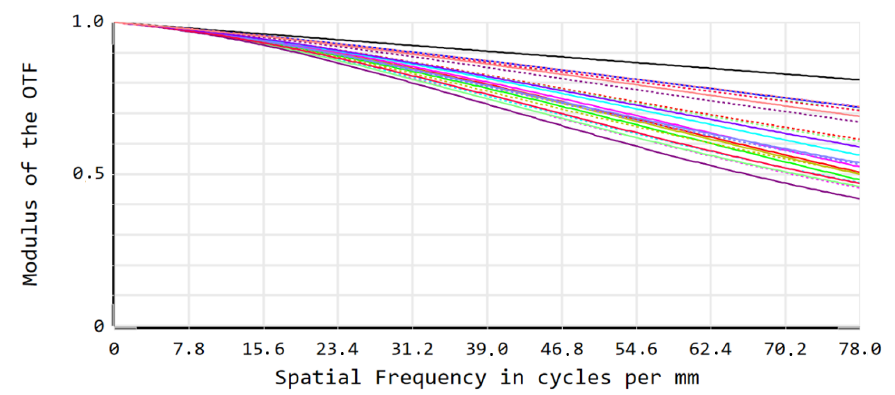
Figure 5. MTF ≥ 0.4 at 78 cycles/mm. The top black line corresponds to the diffraction limit, and the colors correspond to the different fields, similarly to those presented in Figure 2. Full lines and dashed lines correspond to tangential and sagittal planes,